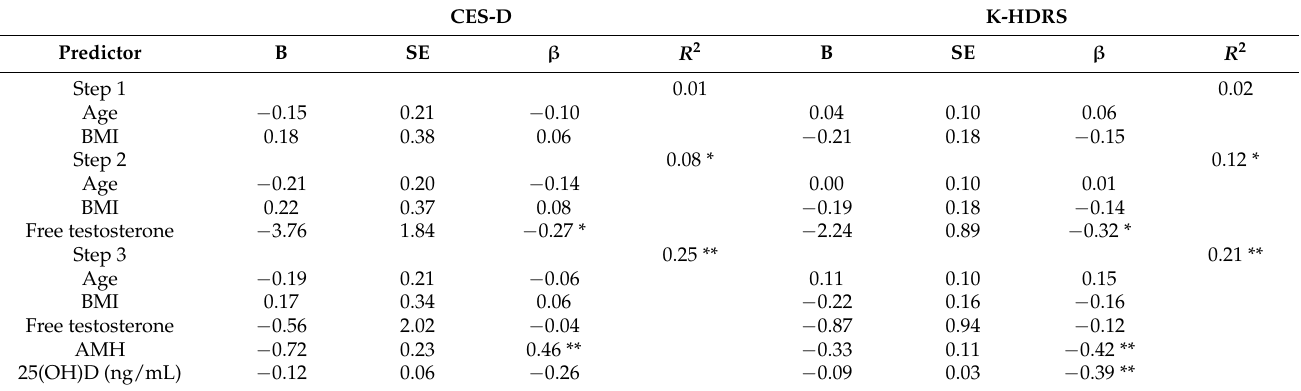
hierarchical regression analysis (Supplementary Material Table S1). Table 3. Hierarchical multiple regression analysis. Table 3. Hierarchical multiple regression